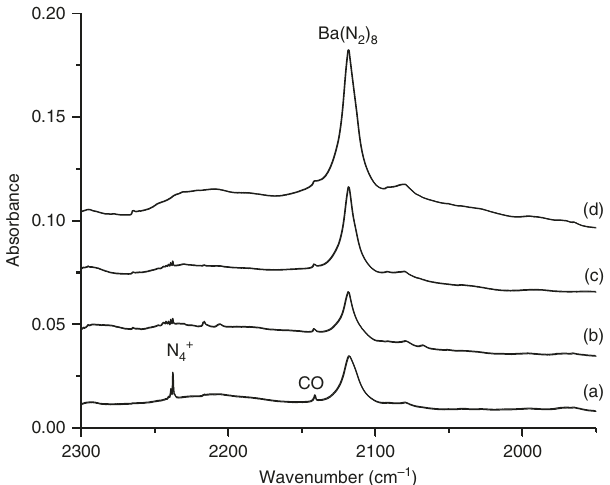
Fig. 1 Infrared absorption spectra of barium dinitrogen complexes. Infrared absorption spectra in the 2300 – 1950 cm − 1 region from co-deposition of laser-evaporated barium atoms with 0.5% N 2 in neon. a 30 min of sample deposition at 4 K, b after annealing at 12 K, c after 15 min of visible light irradiation, and d after 15 min of UV-visible light irradiation. A weak band at 2141 cm − 1 is due to trace of CO impurity